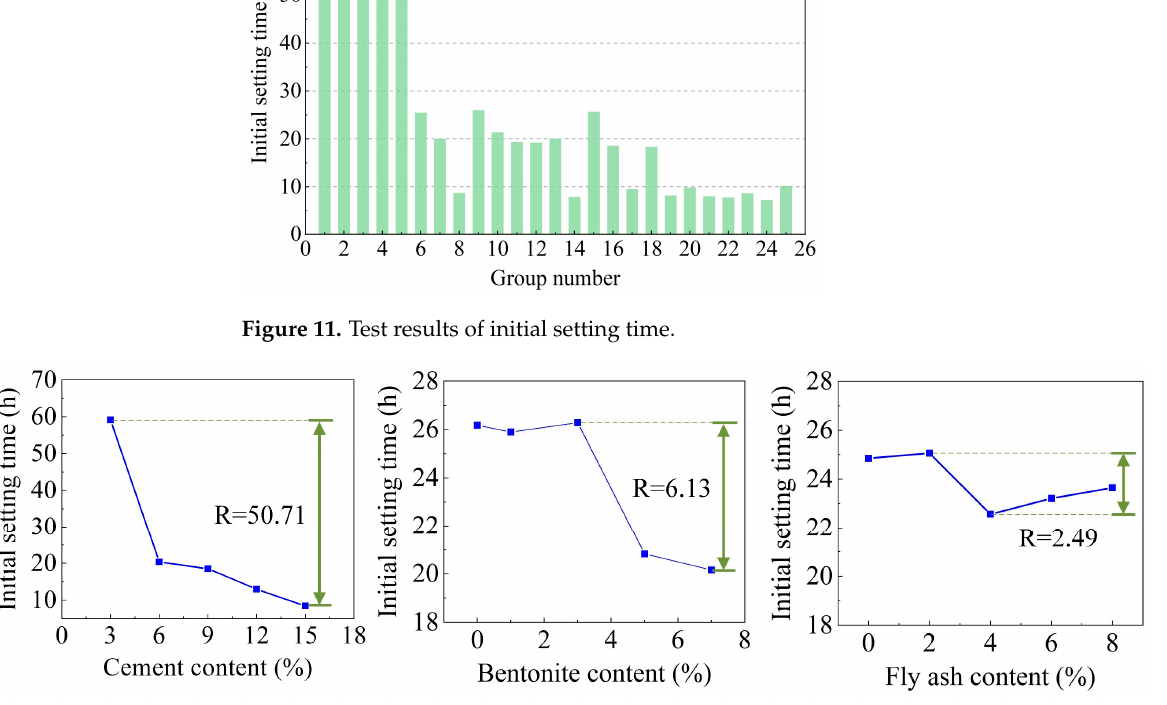
Figure 12. Range analysis of initial setting time.